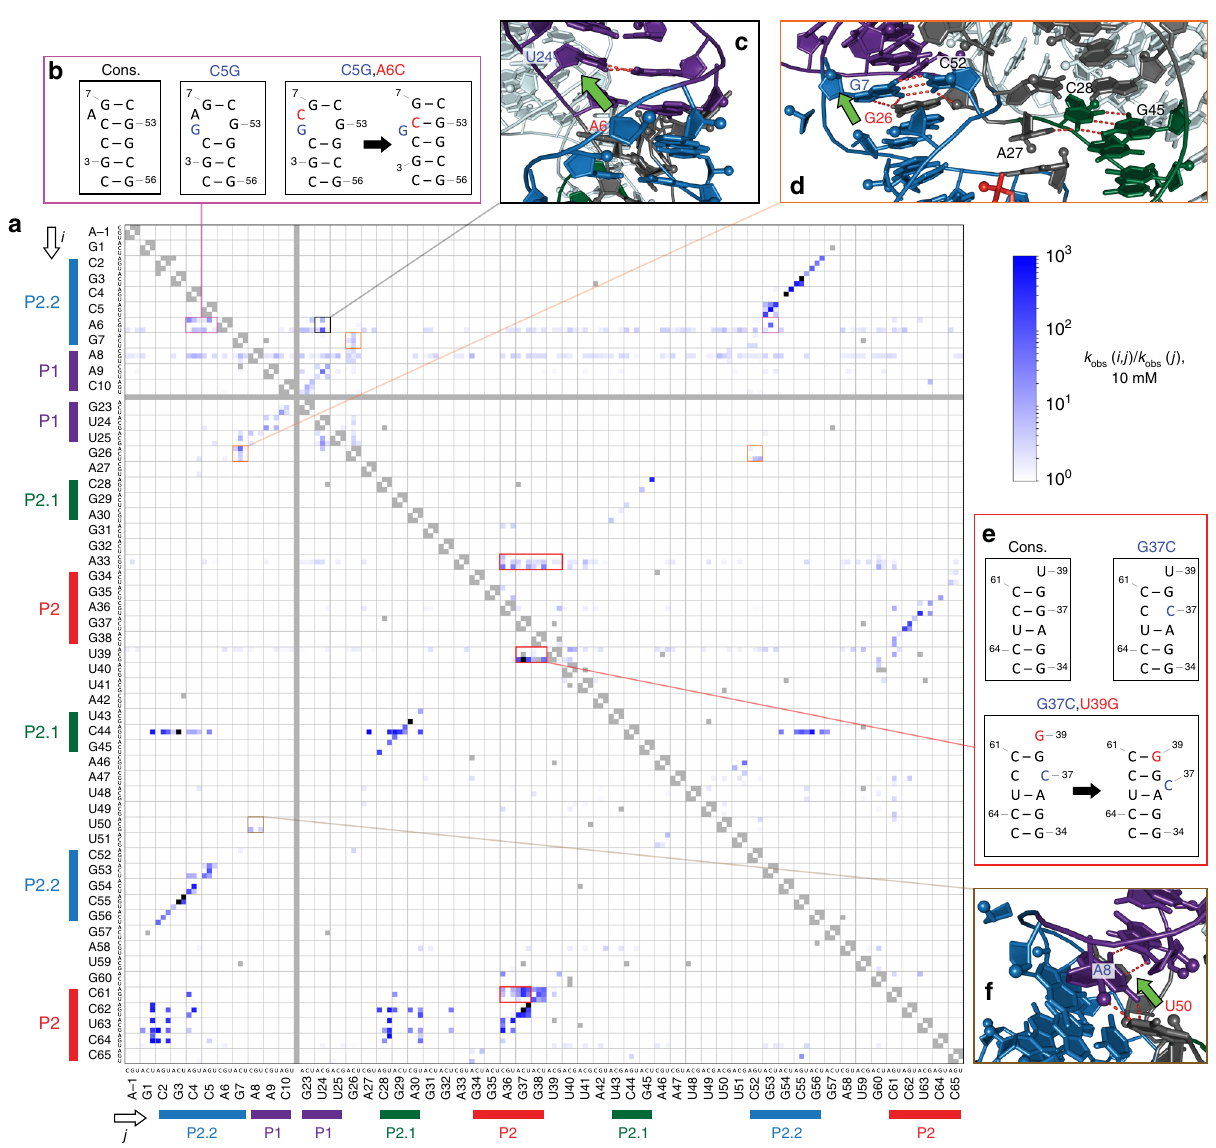
Fig. 5 Double-mutant rescue interactions (for 10 mM GlcN6P). a Heatmap of double-mutant rescue, as de fi ned in the main text. Sequence regions participating in duplex structures are labeled and color-coded, as in Fig. 4. b – f Examples of rescue interactions, illustrating different candidate mechanisms: secondary-structure rearrangements ( b, e ), tertiary contacts seen in crystal structures ( d, f ), and novel tertiary interactions ( c ). The crystal structure in c , d , and f is PDB 2Z75. Source data are available in the Source Data fi